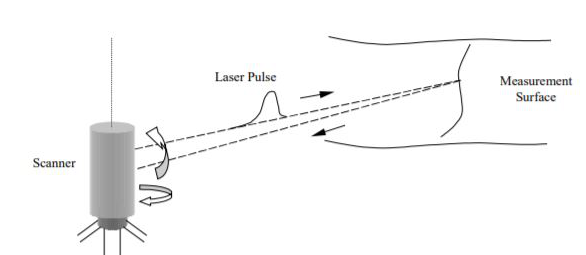
Figure 2. TLS principle (Lichti, Stewart, Tsakiri, & Snow, 2000)